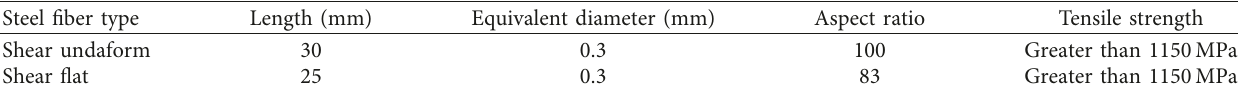
Table 2: Steel fiber performance parameter.